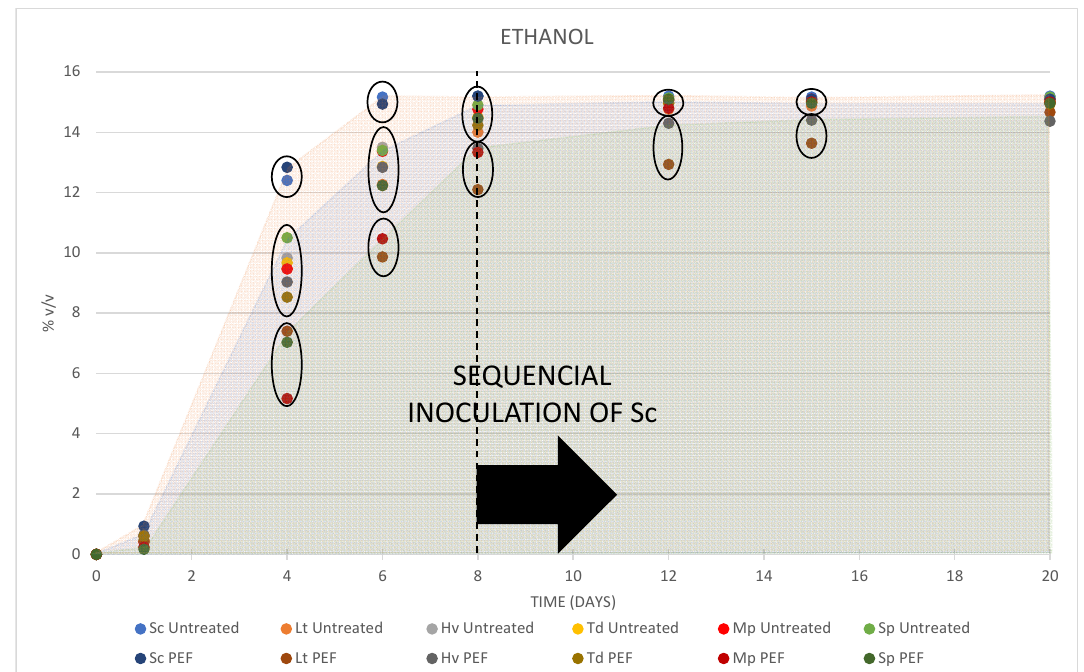
Figure 4. Evolution of the alcoholic strength produced during the fermentation of the different inoculations. The three colours in the figure show the fermentative power before sequential inoculation of the Sc.